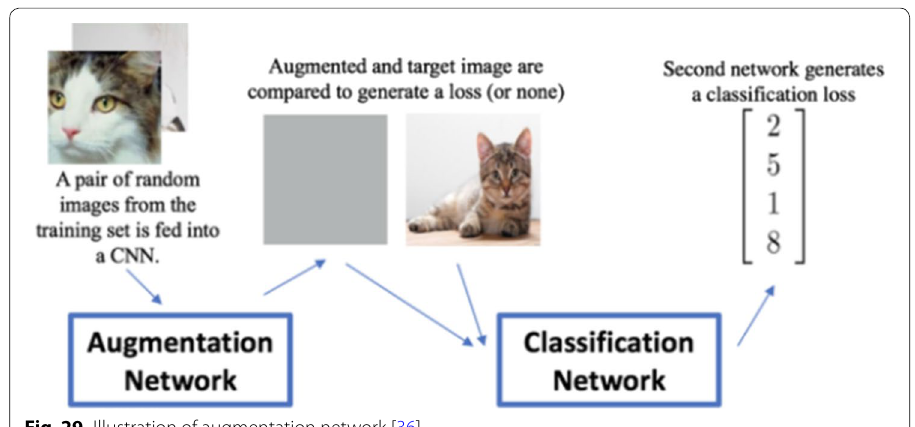
Fig. 29 Illustration of augmentation network